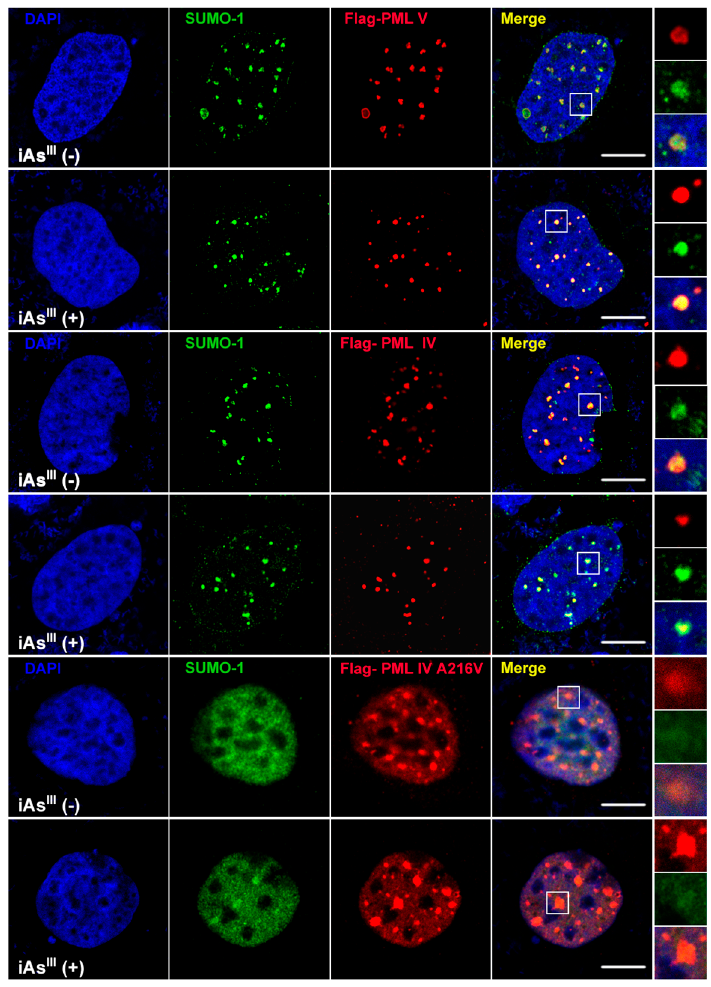
Figure 2. Determination of localization of PML-IV, PML-V and its mutant PML-IV (A216V) in HEK293T cells. Flag-tagged PML-IV, PML-V and point mutated PML-IV (A216V) plasmids were transfected into HEK293T cells for 24 h. After transfection, PML-transfected cells (i.e., PML-IV and -V) were exposed to 4 µM of iAs III for 12 h and then determined by confocal microscopy, with PML primary antibody. Red and green fluorescence indicate PML and small ubiquitin-like modifier-1 (SUMO-1) proteins, respectively; while yellow fluorescence indicates the localization of PML and SUMO-1 proteins. Scale bar, 10 µm.